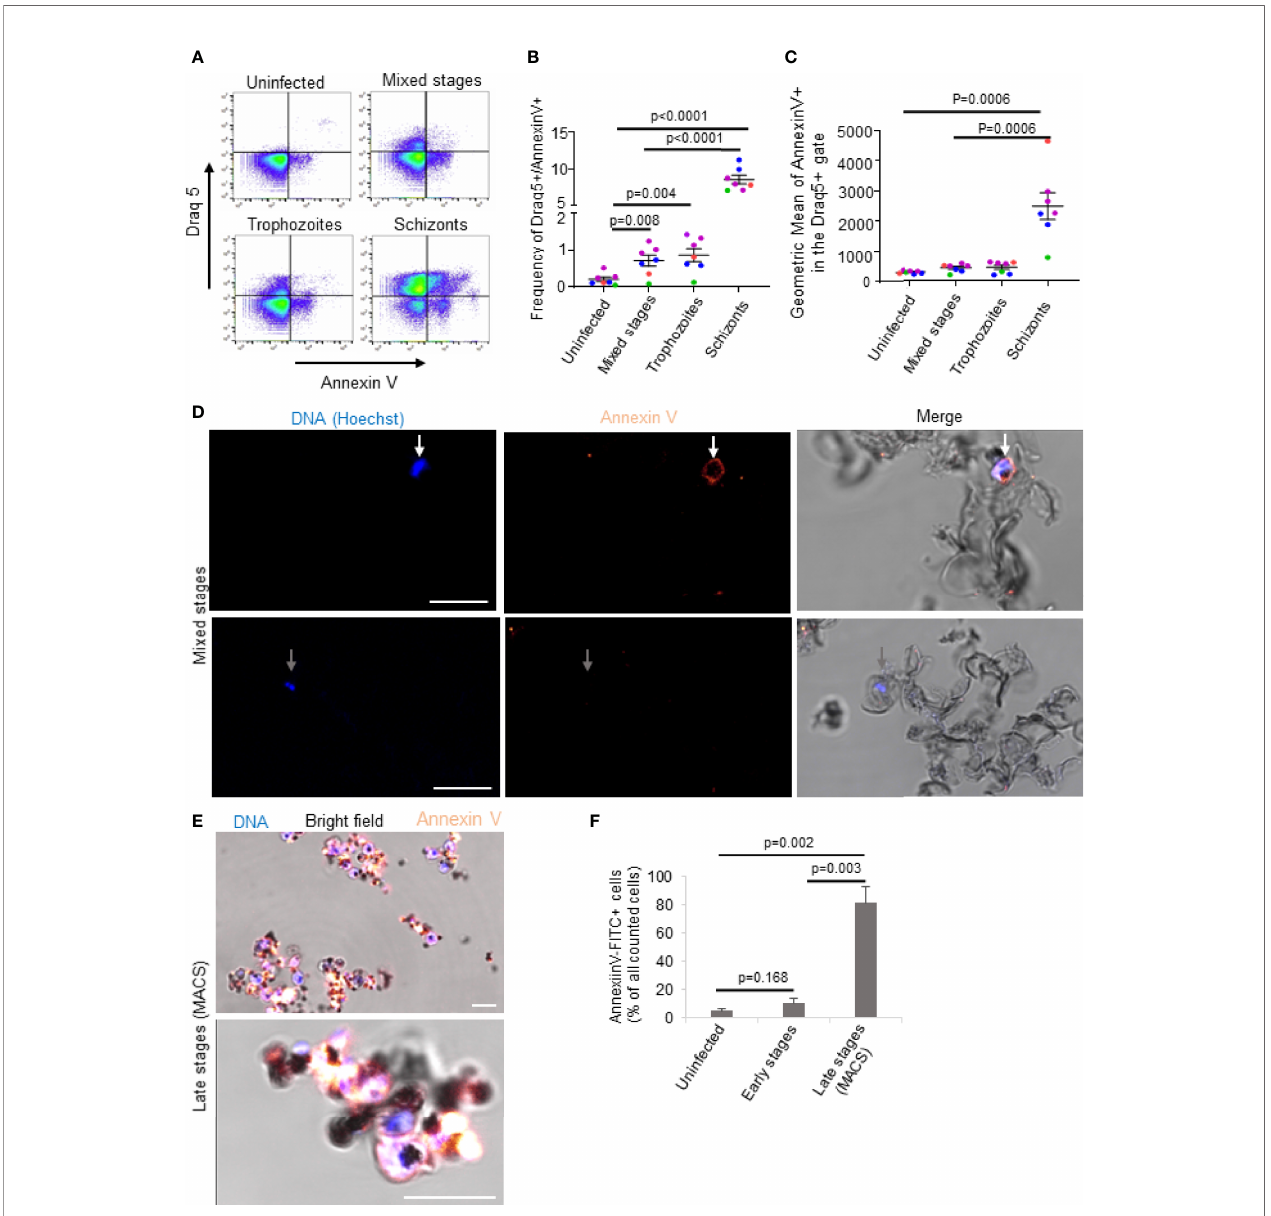
FIGURE 4 | Plasmodium falciparum infection triggers exposure of phosphatidylserine in late stage iRBCs. Uninfected erythrocytes, mixed stages, 75% Percoll enriched trophozoites and 65% Percoll enriched schizonts were incubated with annexin V-FITC and Draq5 for 15min at RT and subjected to fl ow cytometry analysis. A representative FACS dot plot of annexin V versus Draq5 staining is shown in (A) . Averages and values of single experiments represented by dots in different colors indicating frequencies of Draq5+/Annexin V+ are depicted in (B) and indicating geometric mean of annexin V in Draq5 + are presented in (C) . Mixed (D) or MACS- puri fi ed late stage iRBCs (E) were stained with Annexin V-FITC for 60 minutes on ice before fi xation and analysis by confocal microscopy. Nuclei were stained with Hoechst. Representative images of three independent experiments are shown in (D, E) . In (D) , scale bars are 10 m m. The quanti fi cation of the microscopy results and presentation as averages +/- SEM is shown in (F) . P values of differences between stages were calculated with the unpaired t-test (B, F) or Mann-Whitney test (C) . Independent experiments are represented in different colors and replicates by symbol in (B, C)